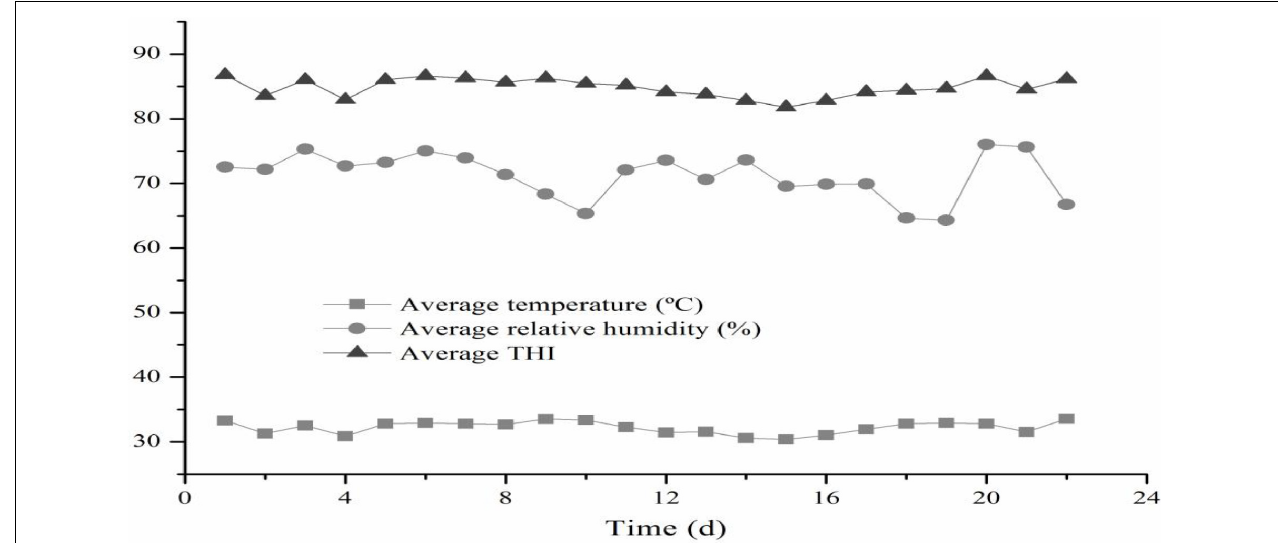
FIGURE 1 | Temperature-humidity index in the house of the beef cattle. THI, temperature and humidity index.